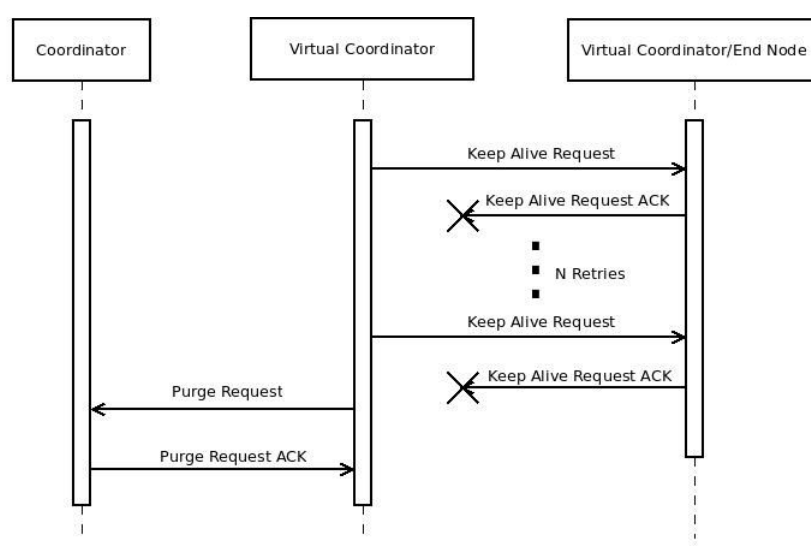
Figure 9. Message flow in a control check or keep alive operation with